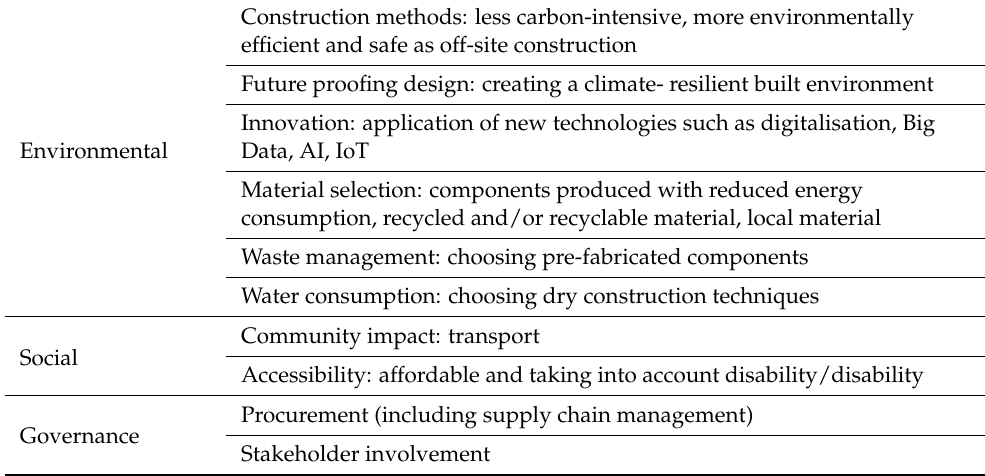
Table 13. ESG issues in refurbishment and retrofitting buildings.